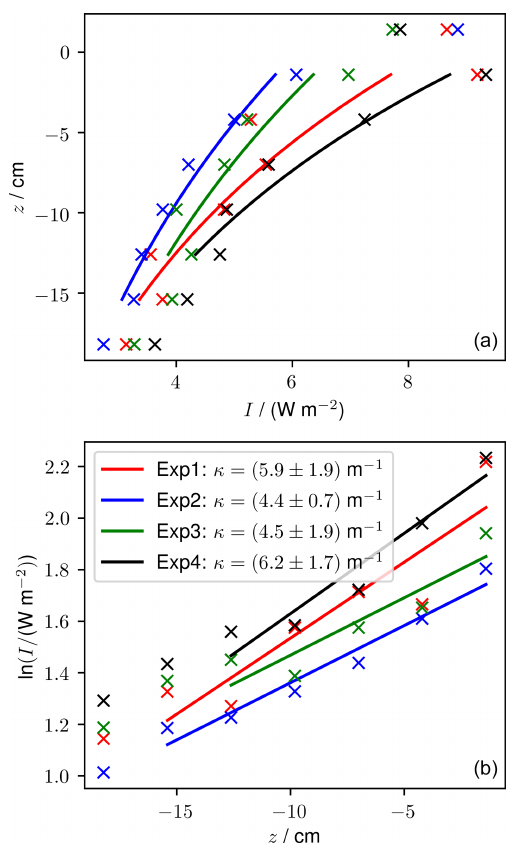
Figure 10. Irradiance profiles (a) and linear regressions of ln (I/ Wm − 2 ) vs. z (b) used to produce extinction coefficients (Eqs. 8 and 9) from the final profile of the freezing period. The legend in (b) gives the extinction coefficient for a given profile with 1 standard